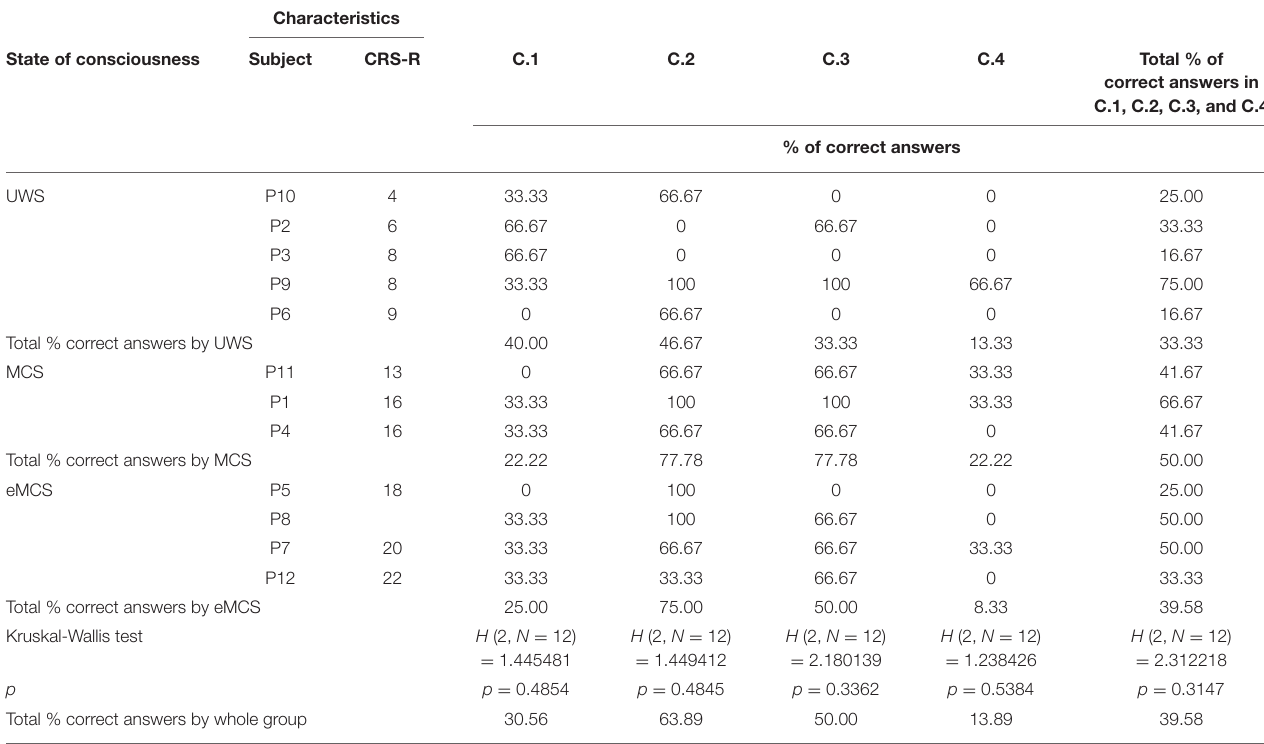
TABLE 2 | Results of the study group by state of consciousness.